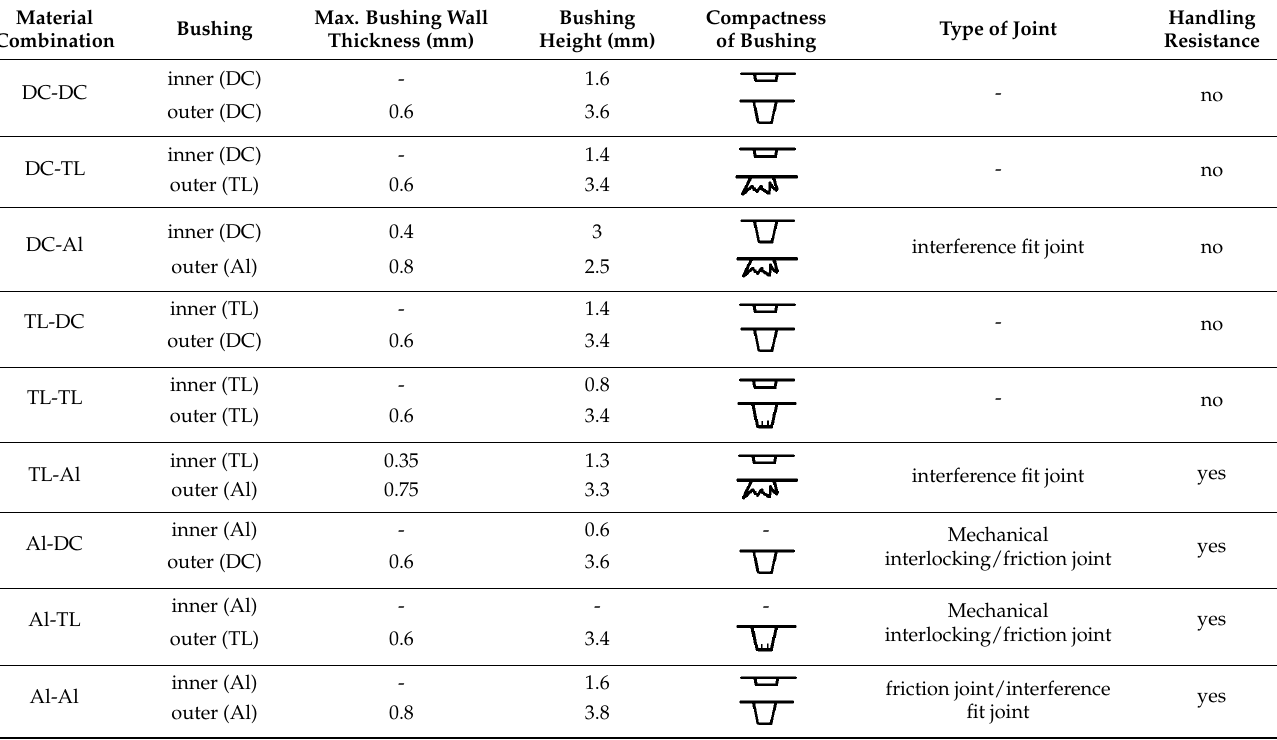
—long compact bushing 53. —long bushing with little cracks 54. —short bushing 55. —bushing with